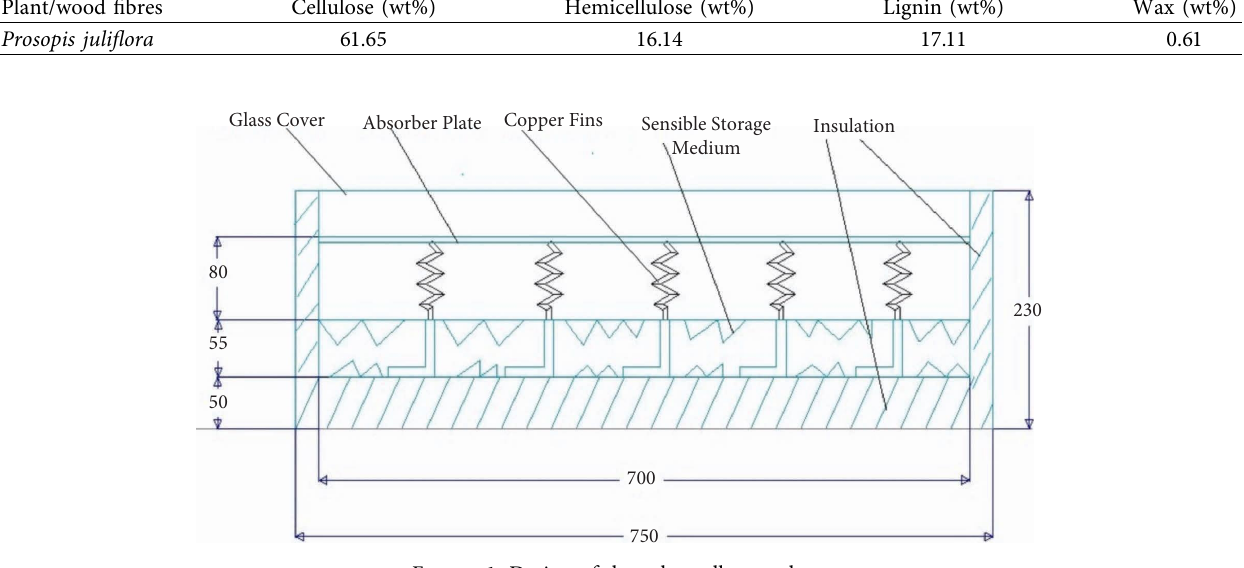
Figure 1: Design of the solar collector plate.